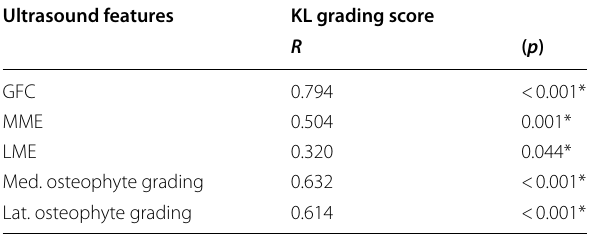
WOMAC score Western Ontario and McMaster Universities Osteoarthritis score, GFC global femoral cartilage, MME medial meniscal extrusion, LME lateral meniscal extrusion, r Spearman’s correlation, p p value for comparing between the studied groups *Statistically significant at p 0.05 ≤ Table 4 Correlation between radiological and ultrasound